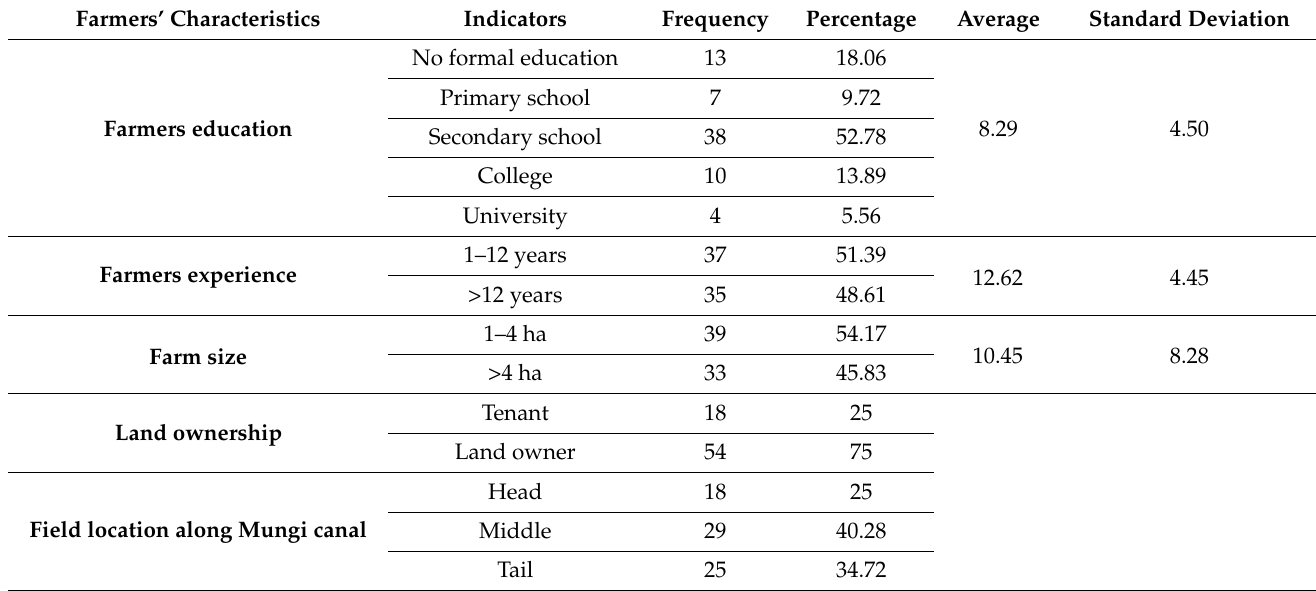
Table 1. Heterogeneous attributions of the farmers (total participants =